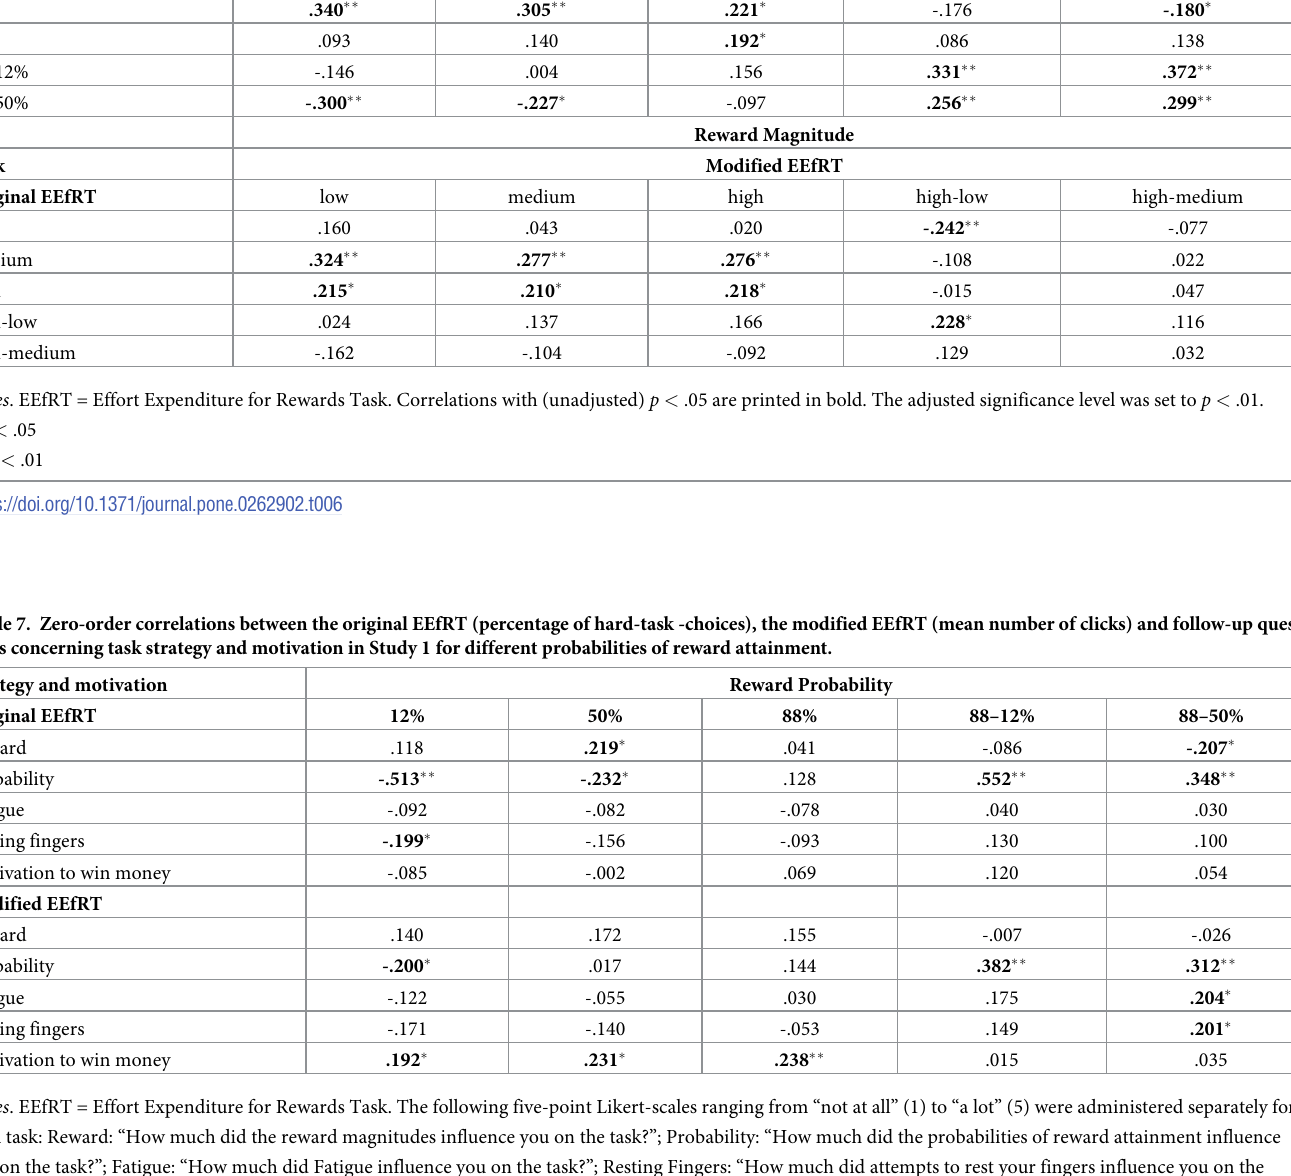
Reward Probability